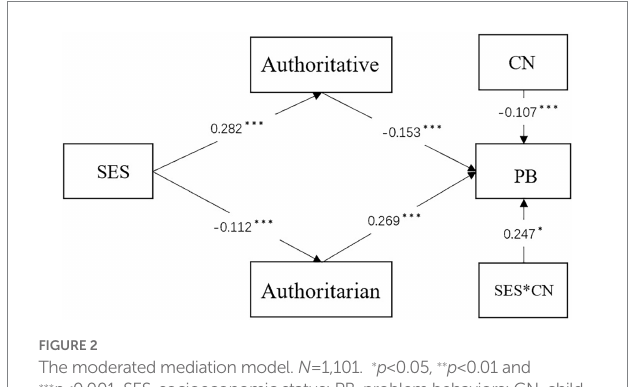
FIGURE 2 The moderated mediation model. N = 1,101. ∗ p < 0.05, ∗∗ p < 0.01 and ∗∗∗ p < 0.001. SES, socioeconomic status; PB, problem behaviors; CN, child